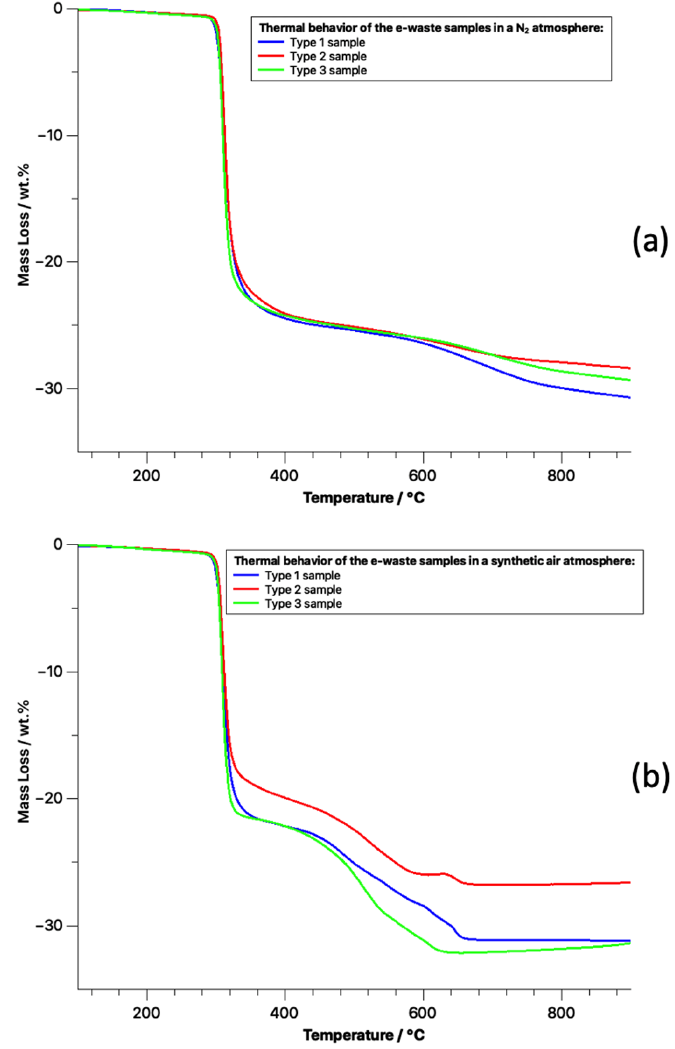
Figure 9. Thermal behavior characterization of WEEE sample: ( a ) in an inert atmosphere; ( b ) in an oxidizing atmosphere.